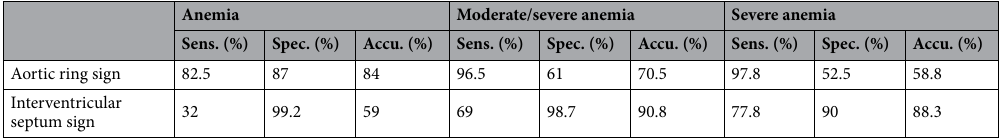
Table 6. Diagnostic accuracy of aortic ring sign and interventricular septum sign for different severities of anemia.